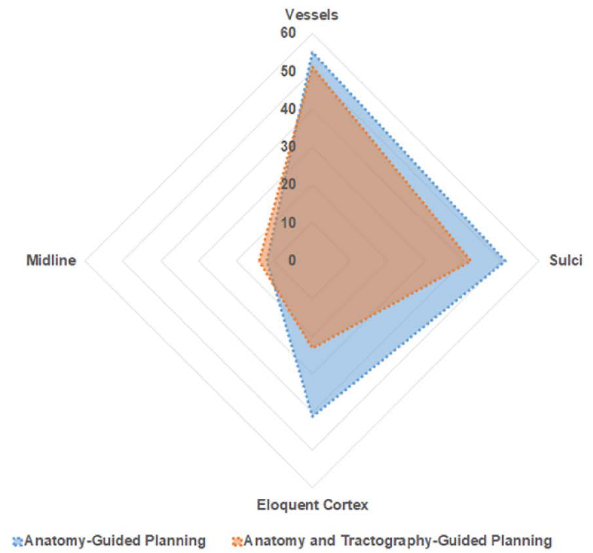
Figure 4. Trajectory Safety Index—Area plot—explaining distribution of trajectories in relation to proximity to neurovascular structure. Blue—represents A-nBx group; Red—represents T-nBx group.